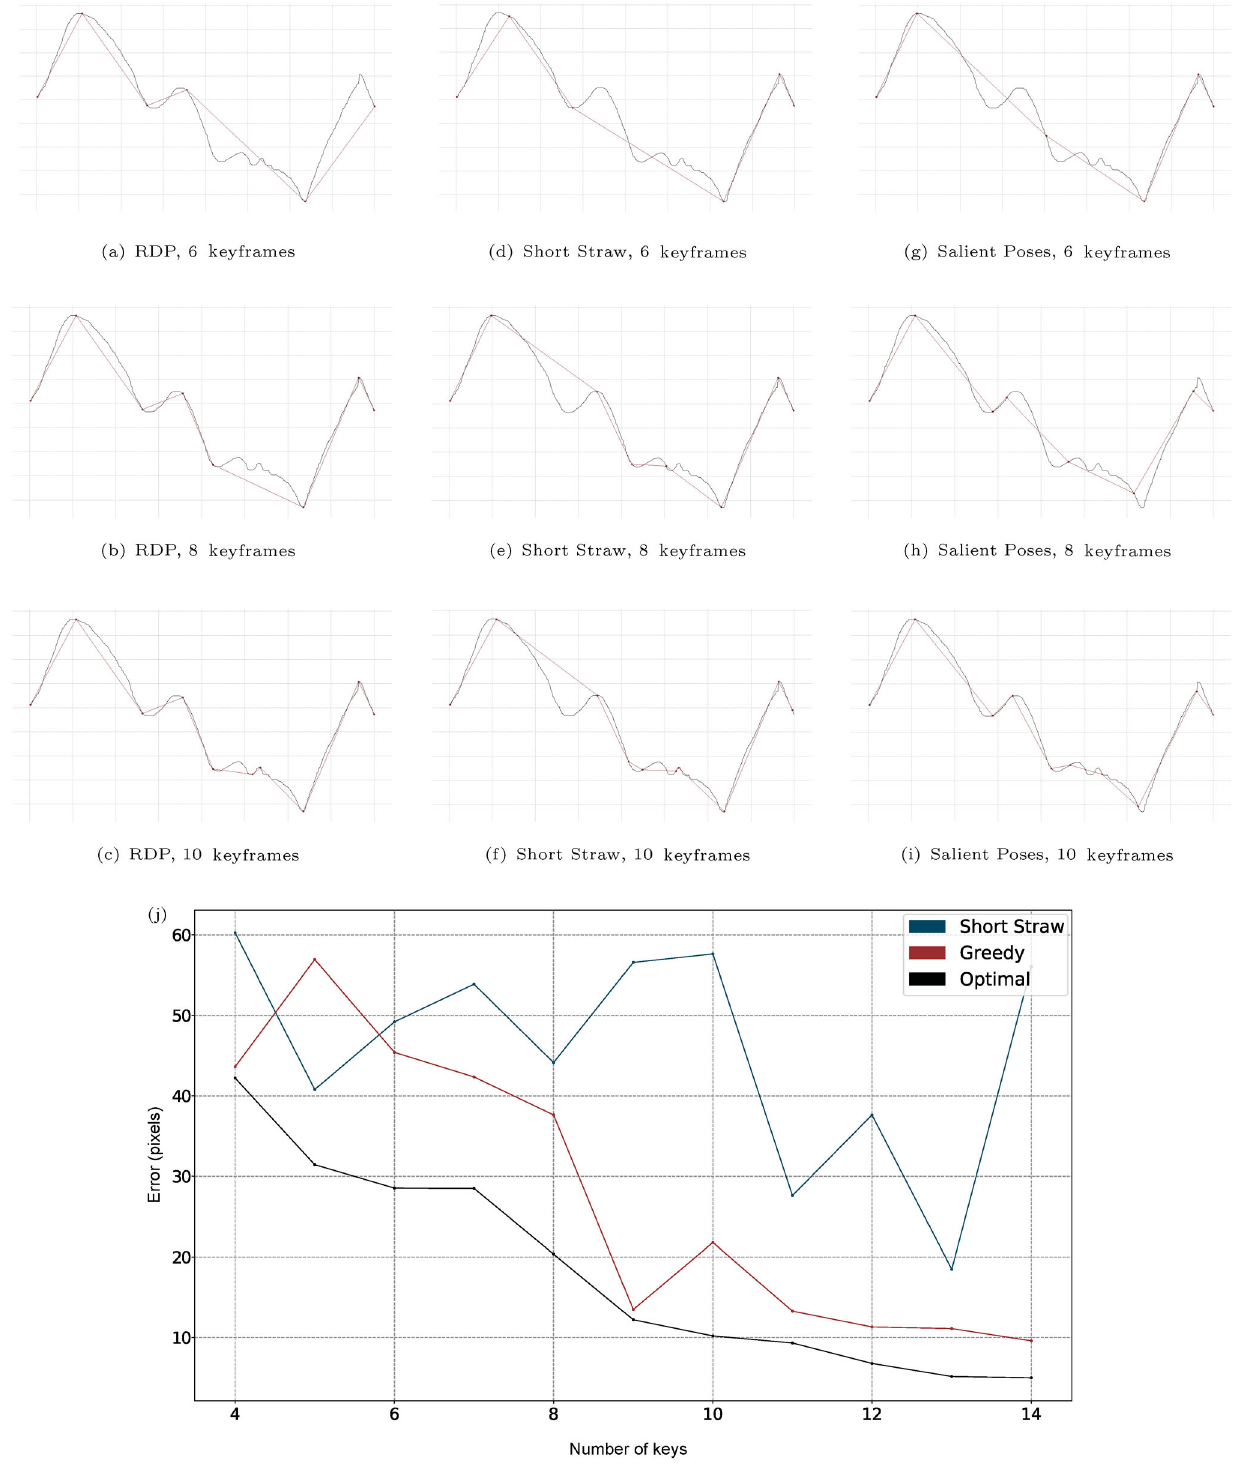
Fig. 7 Comparison of how well keypoints selected by three methods approximate a digitized hand-drawn curve. (a)–(c) result from the greedy approximation (RDP [5]), (d)–(f) result from a finite-differences approach (Short Straw [11]), and (g)–(i) result from our algorithm (Salient Poses, adjusted to serve as an optimal keypoint selection algorithm). In the graph (j), the horizontal axis plots the number of keypoints and the vertical axis plots the approximation error of each solution (the maximum perpendicular distance between a linear interpolation of keypoints and the original curve). The vertical axis units are pixels, obtained from a plotting program used to generate the